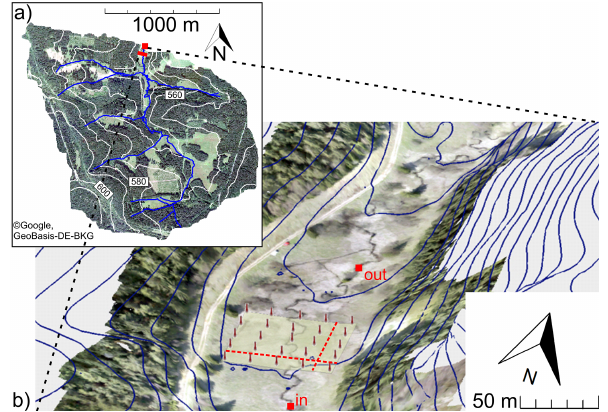
Figure 1. (a) Rappbode catchment and position of the study site (red square). (b) 3D view of the study site (red squares indicate in- let and outlet stream gauges). Red pins indicate the soil sampling transect and the piezometer network. Locations of electric resistiv- ity tomography are indicated by dashed red lines. Note the 2.5-fold vertical exaggeration. Map data: © Google,